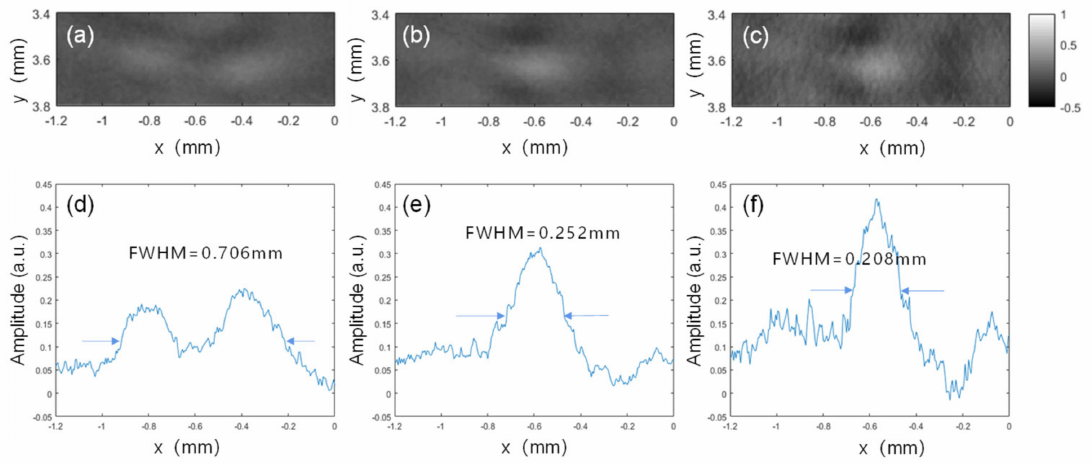
Figure 7. Enlarged views of the reconstructed images with different BP methods for one representative point target. ( a ) The conventional BP method; ( b ) the TDC-BP algorithm; ( c ) The SIR-BP algorithm. ( d – f ) The extracted lateral profiles correspondingly in ( a – c